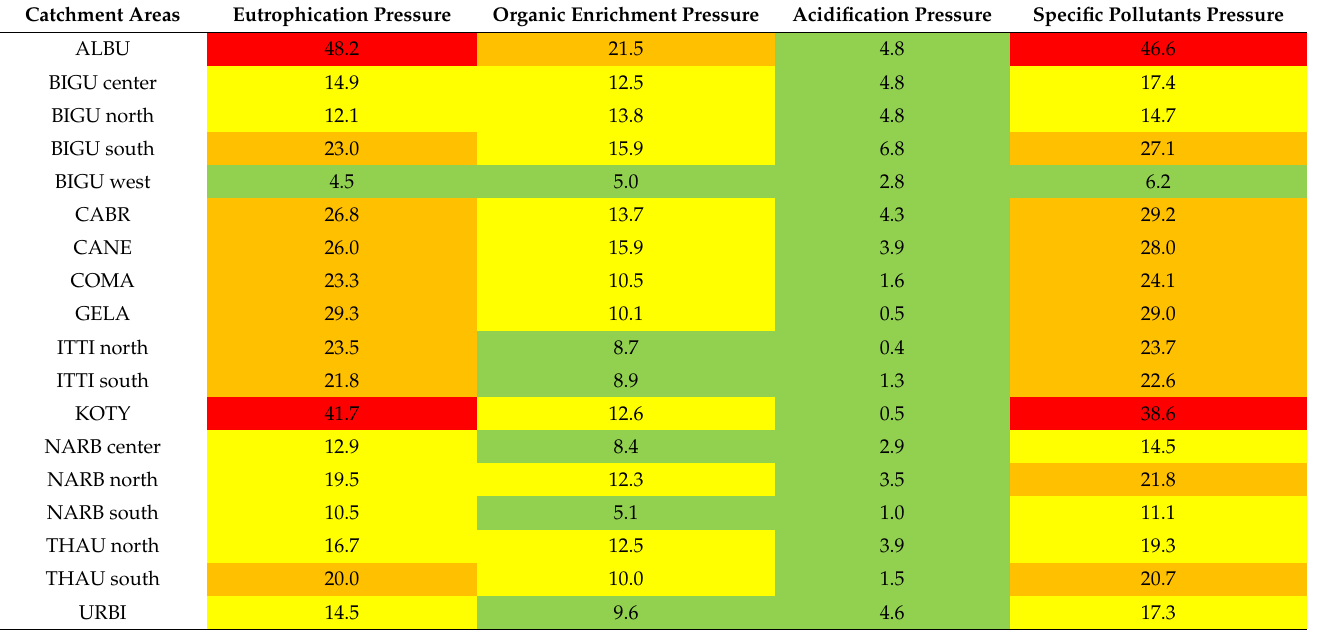
Figure 4. Percentage of land uses from which the pressure levels were obtained for the whole catchment area of the studied coastal lagoons. BIGU, ITTI, NARB and THAU values show data for the whole catchment by the addition of the relative coverage in sub-catchment areas. Table 3. Pressure levels estimated from the land uses in the catchment (or sub-catchment) areas for eutrophication, organic enrichment, acidification, and specific pollutants, using the LUPLES method, Equations (2) to (5). Pressure levels are categorized as low (green, 0–10), moderate (yellow, 10–20), high (orange, 20–30), and very high (red,